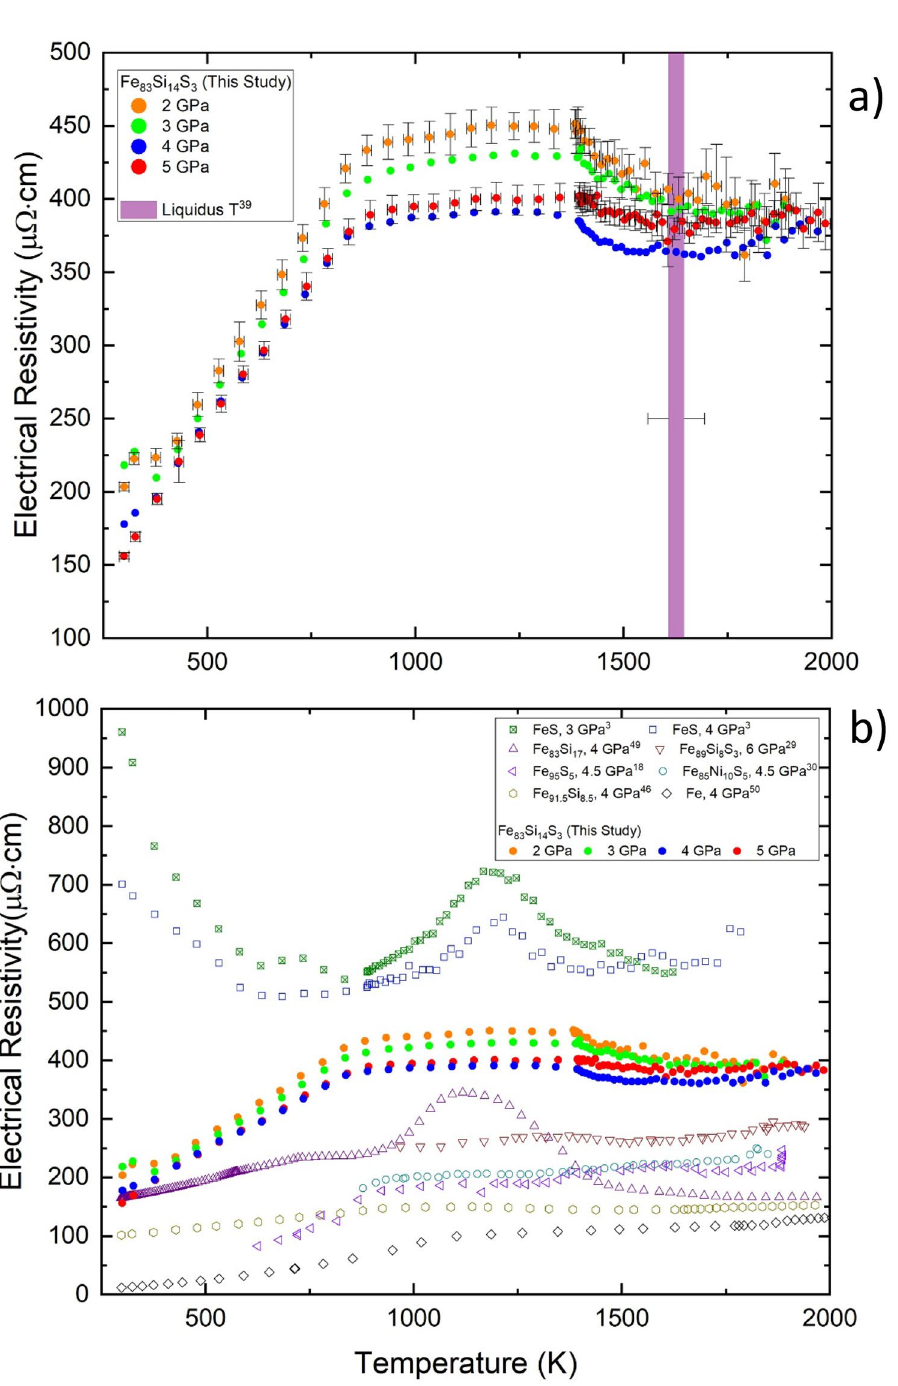
Figure 2. ( a ) Measured electrical resistivity of Fe 83 Si 14 S 3 at pressures of 2–5 GPa (± 0.2 GPa) as a function of temperature. Error bars of T and ρ are shown for all 2 and 5 GPa measurements and are representative for all measurements displayed in the figure. Extrapolated pressure-dependent liquidus temperature estimates of a similar composition within the Fe–Si–S system (Fe 88 Si 4 S 8 ) 39 , are shown by the vertical line spanning the height of the vertical axis. The width of the line corresponds to estimated liquidus temperature from 2 GPa (left side) to 5 GPa (right side) with an uncertainty of ± 50 K. ( b ) Measured electrical resistivity values of Fe 83 Si 14 S 3 from this study are compared to several previous studies of similar or relevant compositions 3,18,29,30,46,49,50